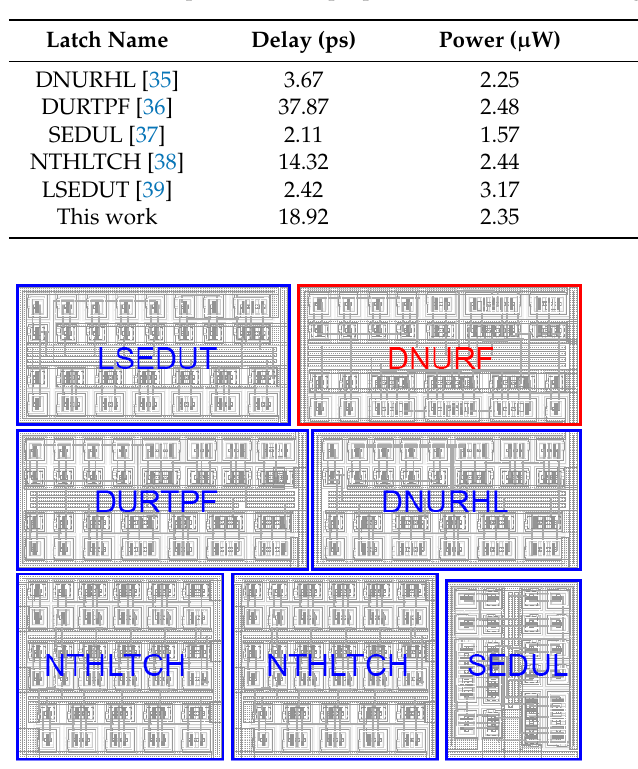
Table 2. Cost comparison of the proposed DNURF with existing hardened latches.